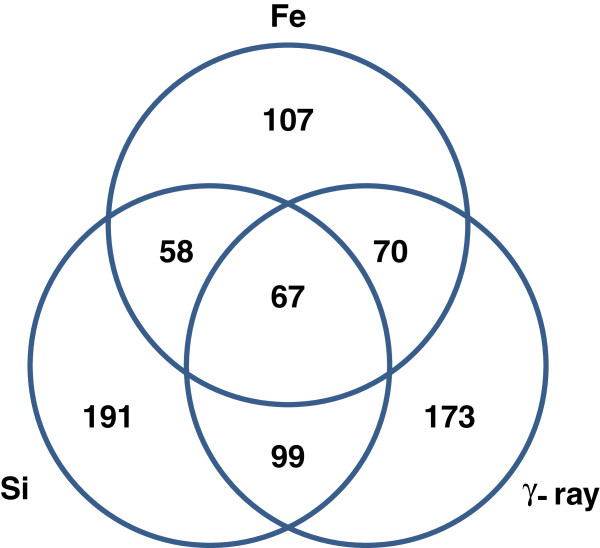
Differentially expressed genes in response to 56Fe, 28Si and γ-ray irradiations. Venn diagram showed the numbers of genes, either specific to or overlapping with different radiation types.